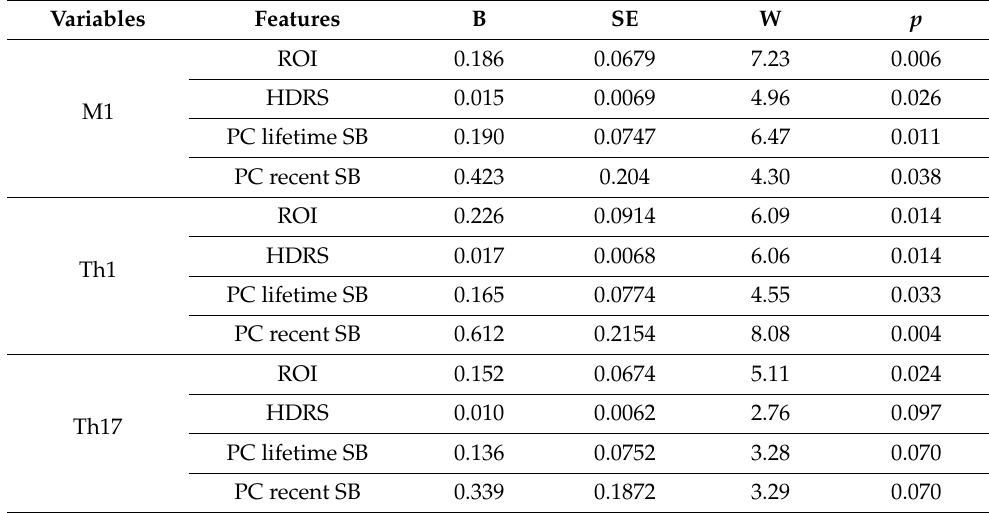
Table 4. Associations between immune/growth factor profiles and the features of major dysmood disorder, namely reoccurrence of illness (ROI), Hamilton Depression rating Scale (HDRS) score, and lifetime and recent suicidal behaviors